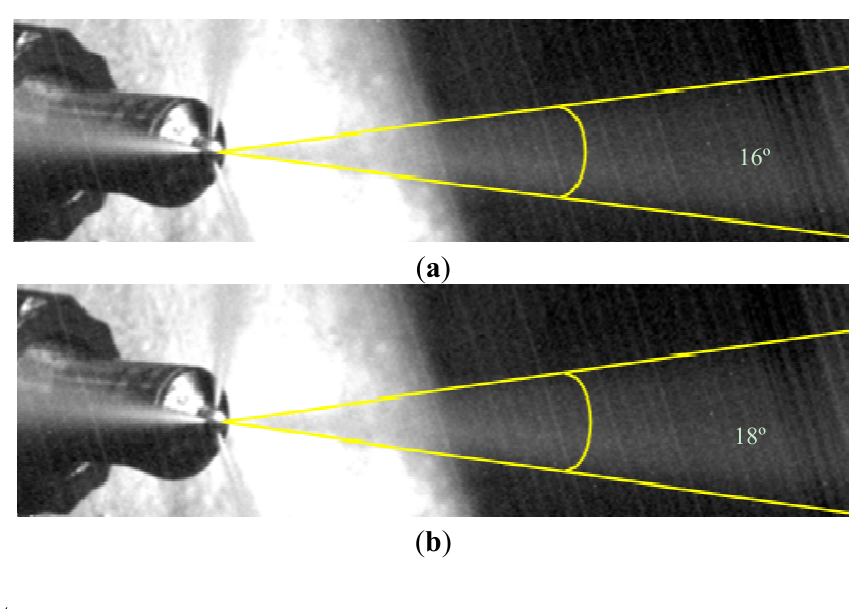
Figure 10. Nozzle test; ( a ) CS-B100; ( b )